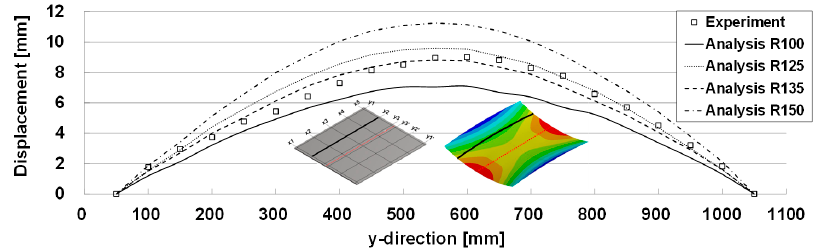
Figure 10. Angular bending deformation results by heat flux radius (x1).